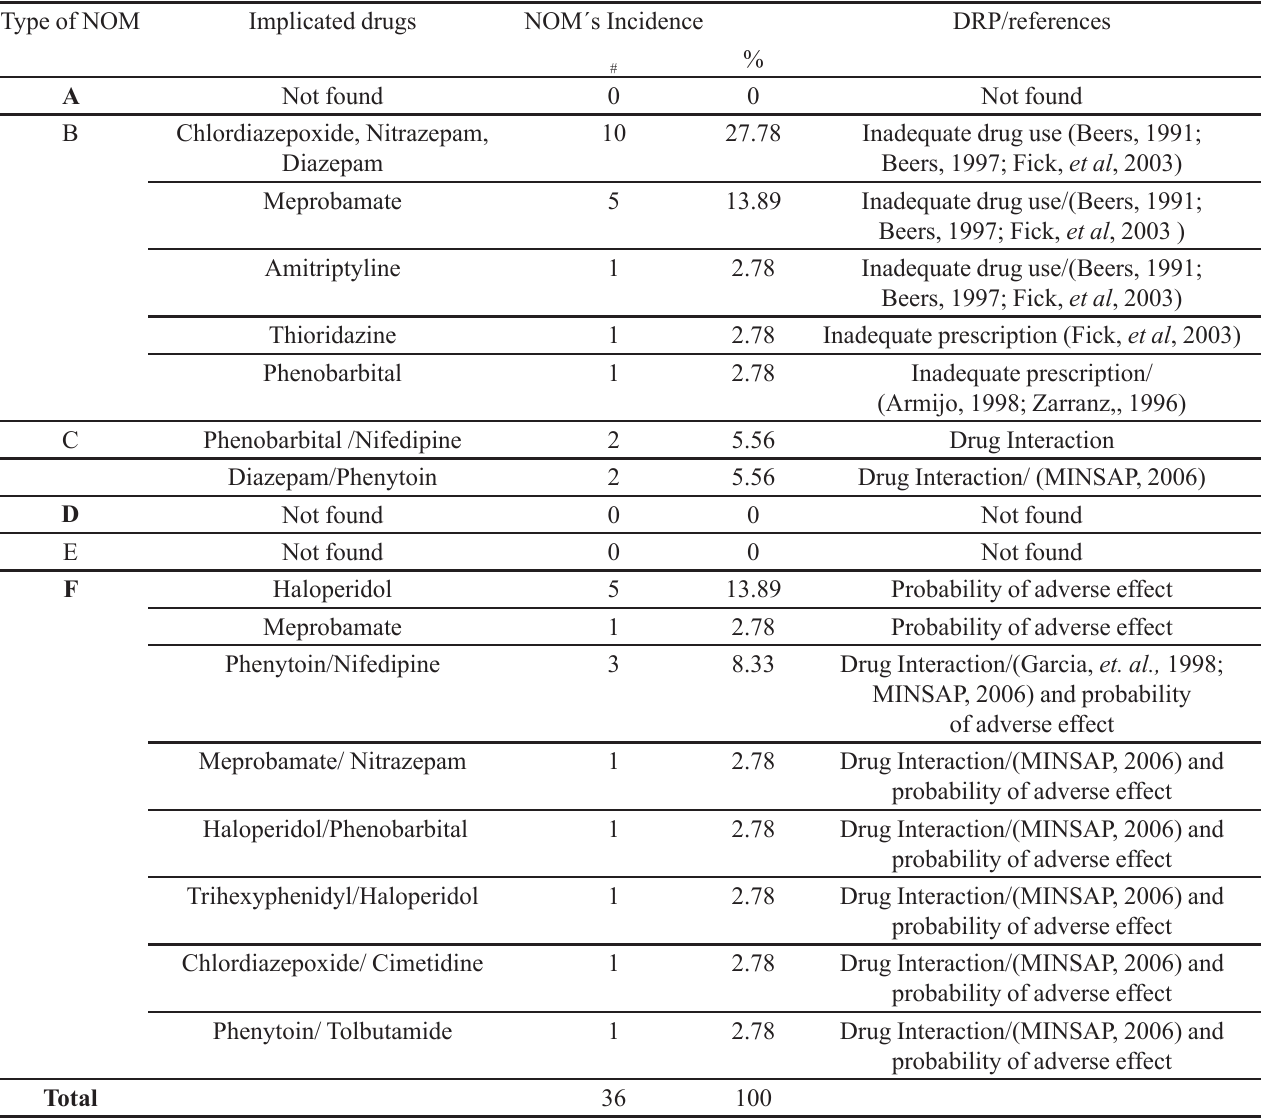
TABLE I - Incidence of DRP according to the type of NOM Type of NOM